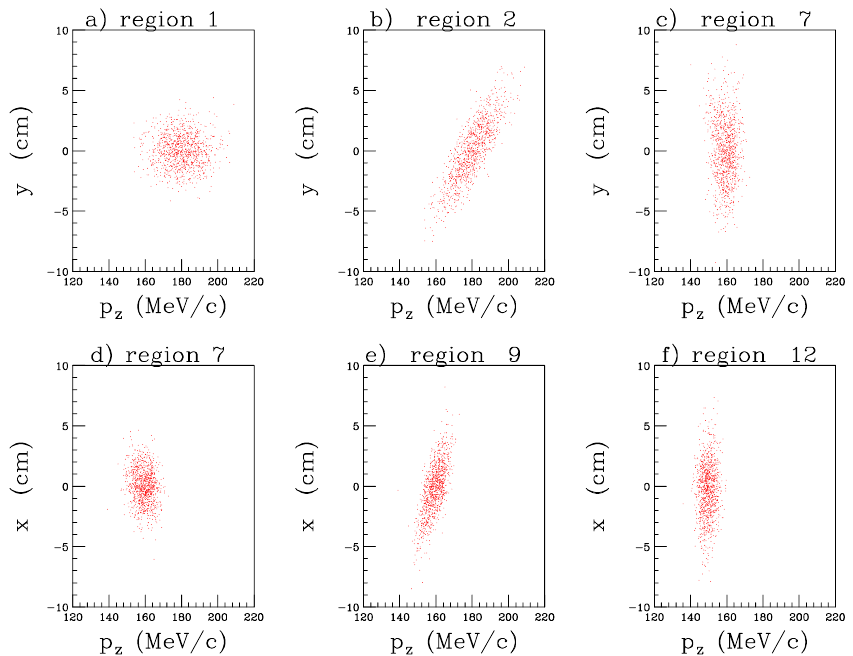
FIG. 32. (Color) y vs p z plots: (a) at the start, (b) after the first bend, and (c) after the first set of wedges. x vs p z plots: (d) after the first wedges, (e) after the second bend, and (f) at the end of the emittance exchange section, following the second set of wedges.